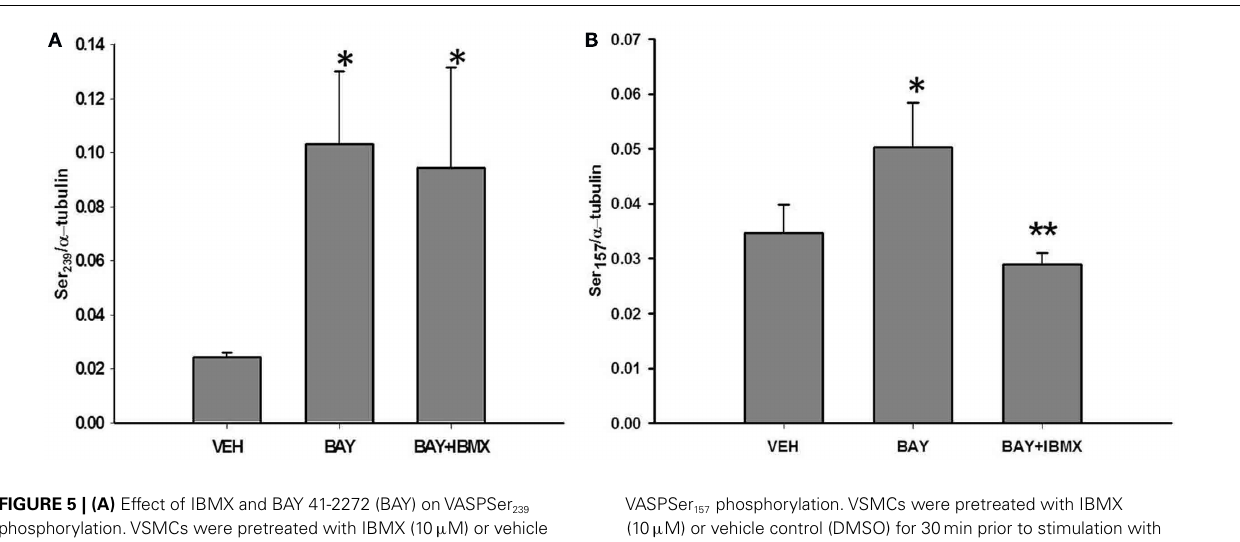
FIGURE 5 | (A) Effect of IBMX and BAY 41-2272 (BAY) onVASPSer 239 phosphorylation.VSMCs were pretreated with IBMX (10 μ M) or vehicle control (DMSO) for 30min prior to stimulation with BAY (10 μ M) for 60min ( n = 5).Values are the means ± SE. *Different from vehicle control ( P < 0.05). (B) Effect of IBMX and BAY 41-2272 (BAY) on